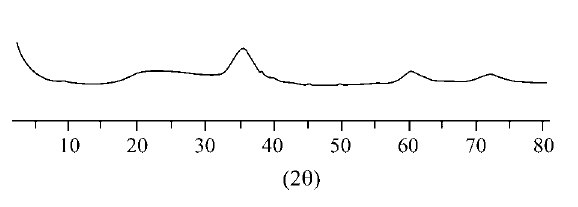
Figure 1. XRD of the ceramic powder obtained from the pyrolysis of the PMS/TAS, at 1000 °C, under argon